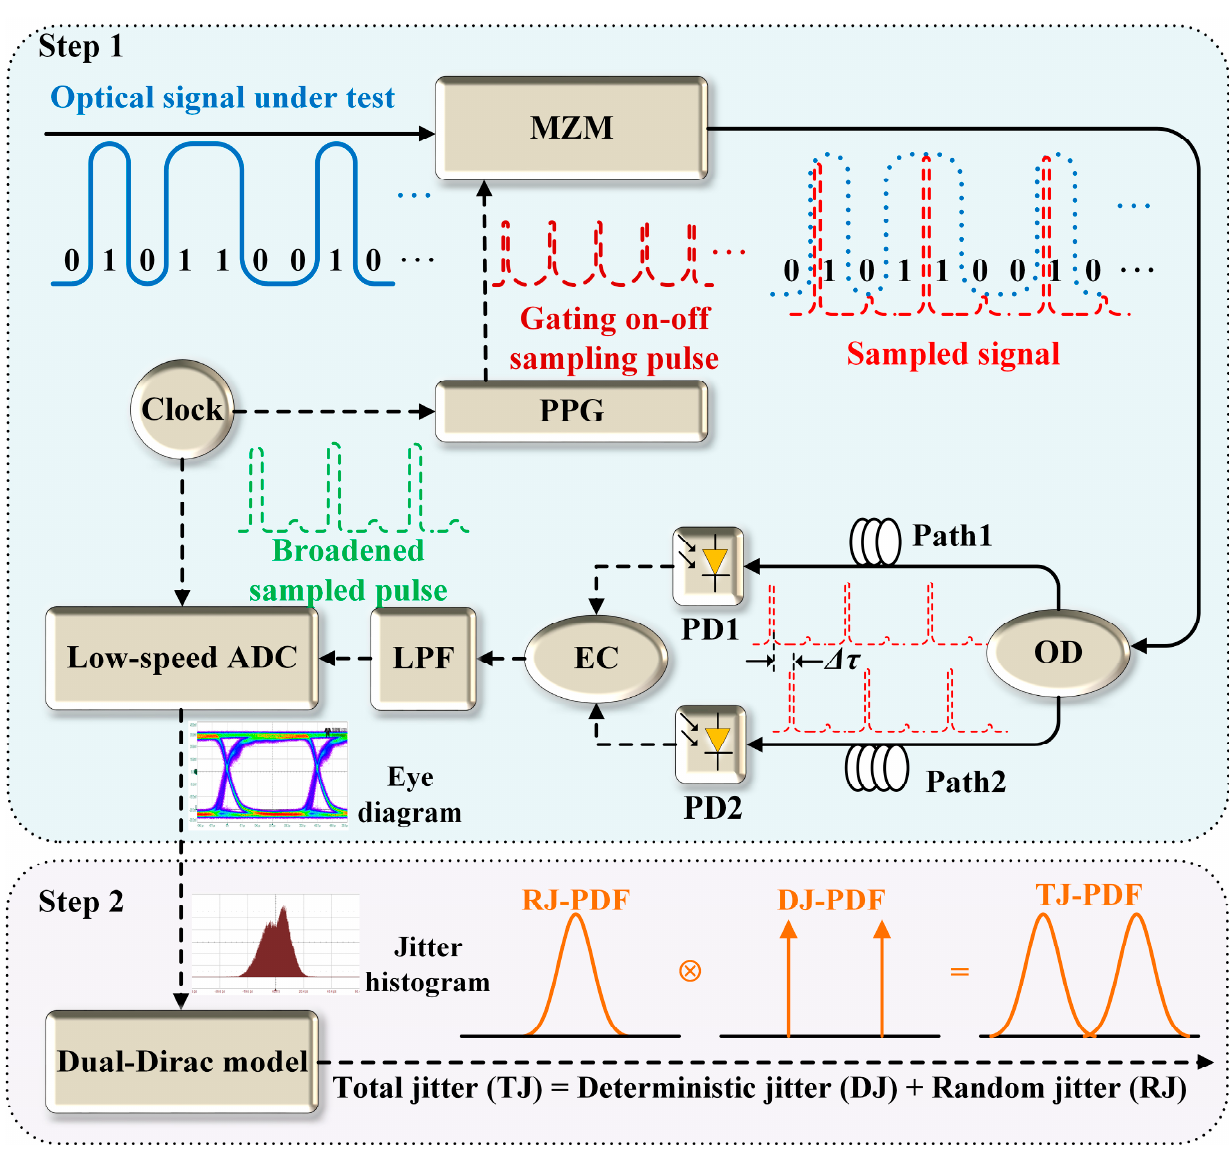
Figure 1. Schematic diagram of the proposed time jitter analysis method for an optical signal. MZM: Mach–Zehnder modulator; OD: optical divider; PD: photodetector; EC: electrical coupler; LPF: low ‐ pass filter; PPG: pulse pattern generator; ADC: analog ‐ to ‐ digital converter; PDF: probability distri ‐ bution function.